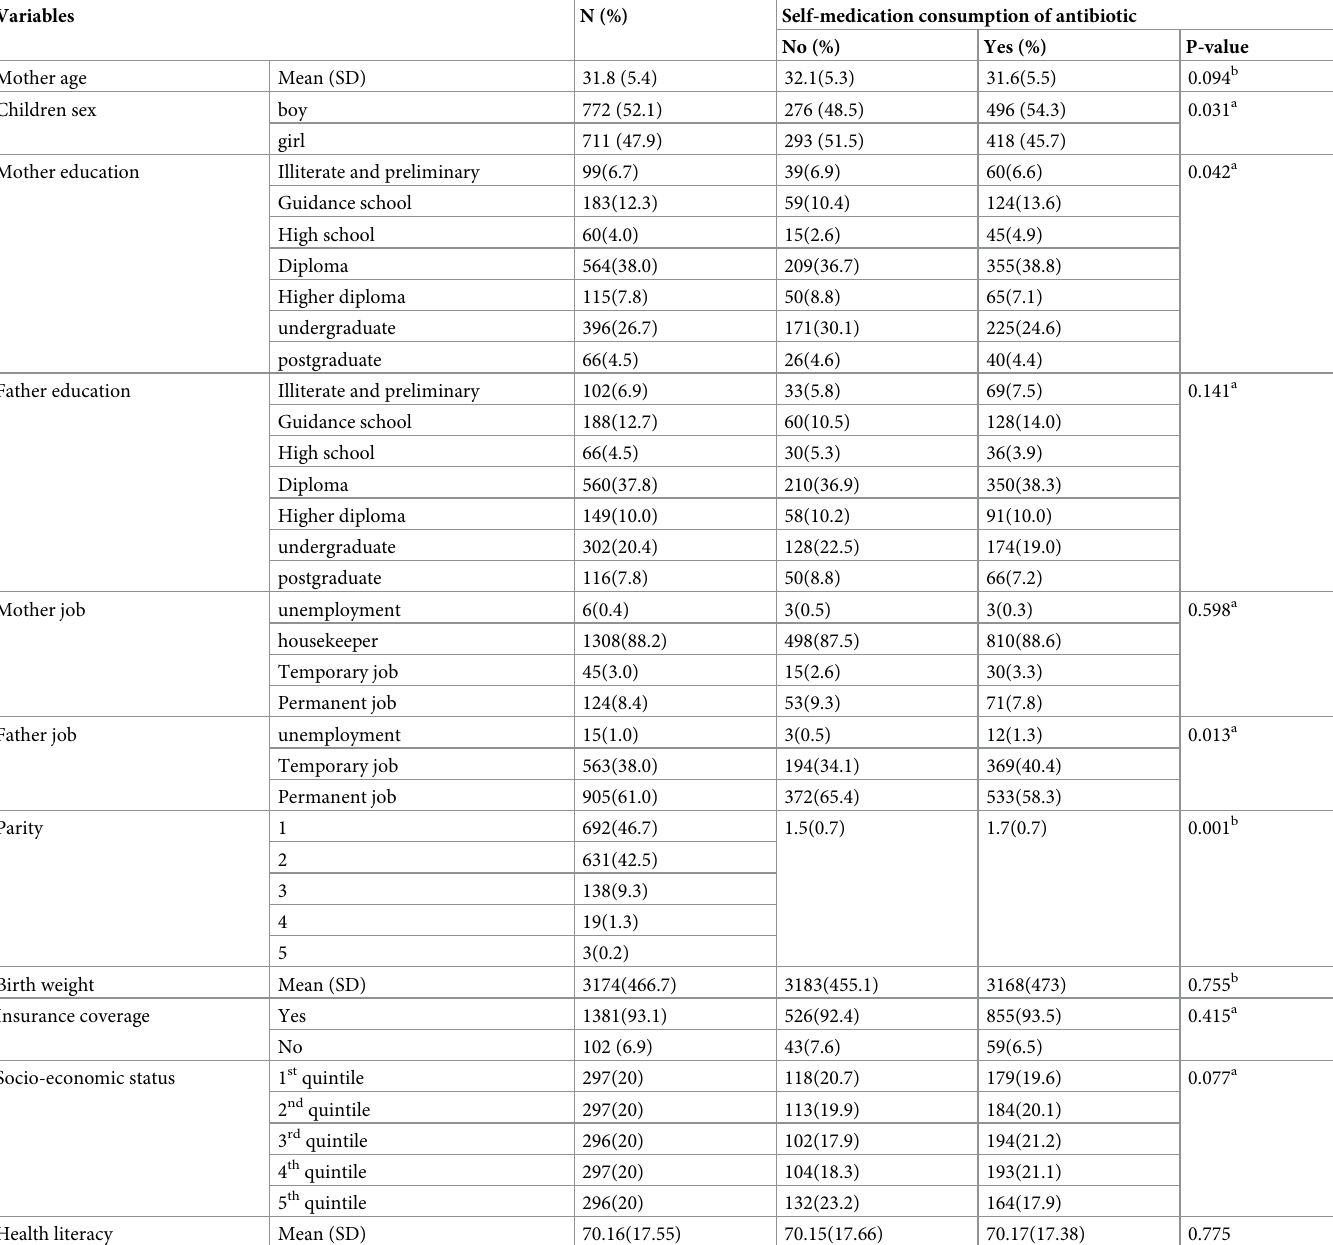
Table 1. Demographic characteristics of the maternal self-medication consumption of antibiotic among children under 6 years, 2018–2019.